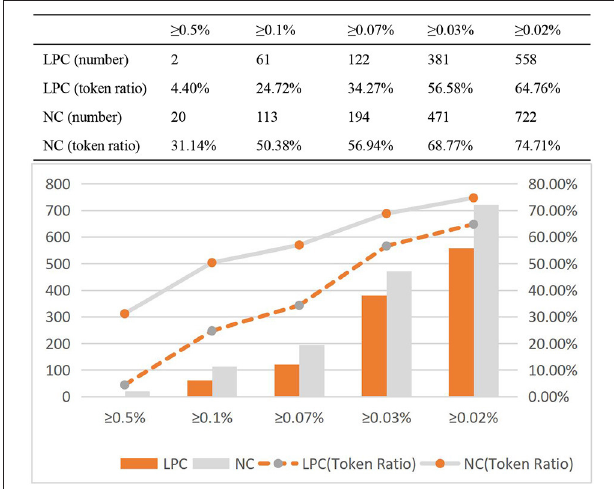
FIGURE 5 | Token ratio distribution of high frequency words of LPC and NC.